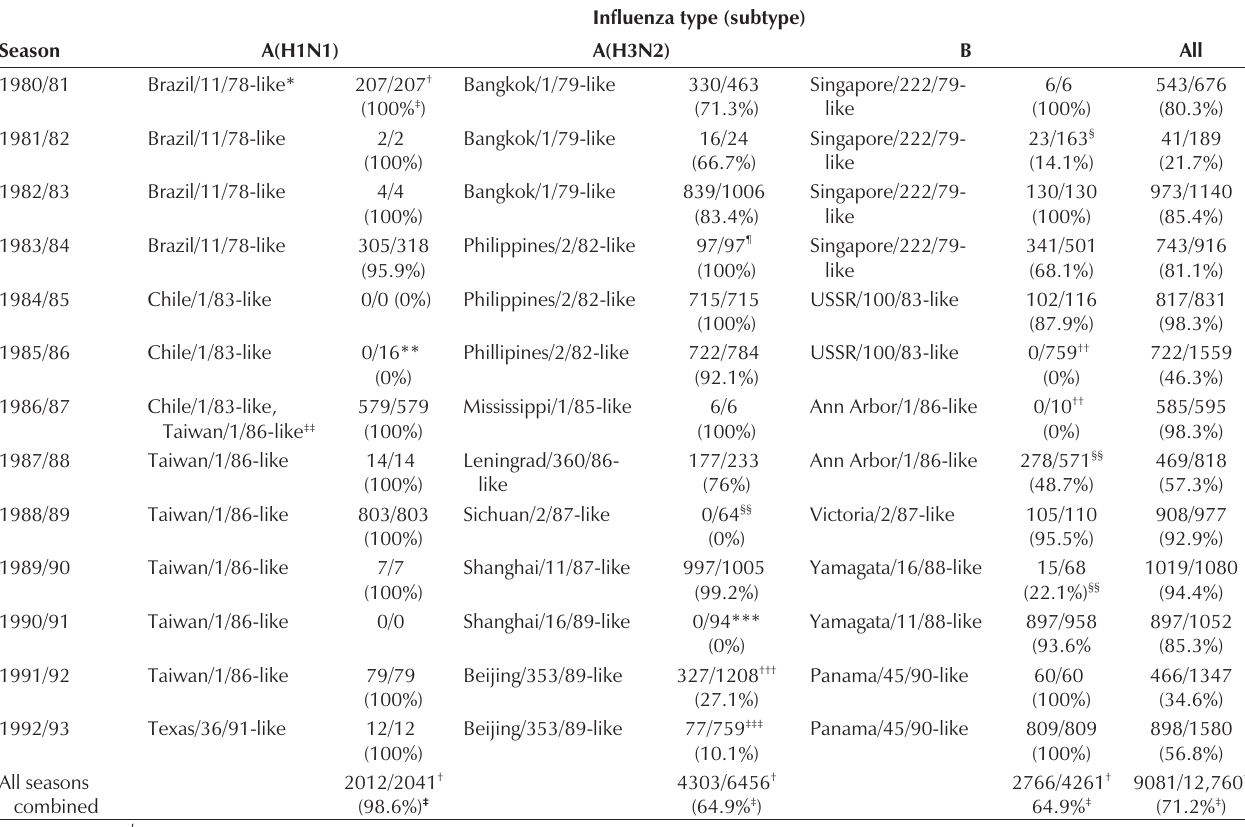
Similarity of laboratory-confirmed influenza infections with vaccine antigens, Canada, 13 seasons (1980/81 to